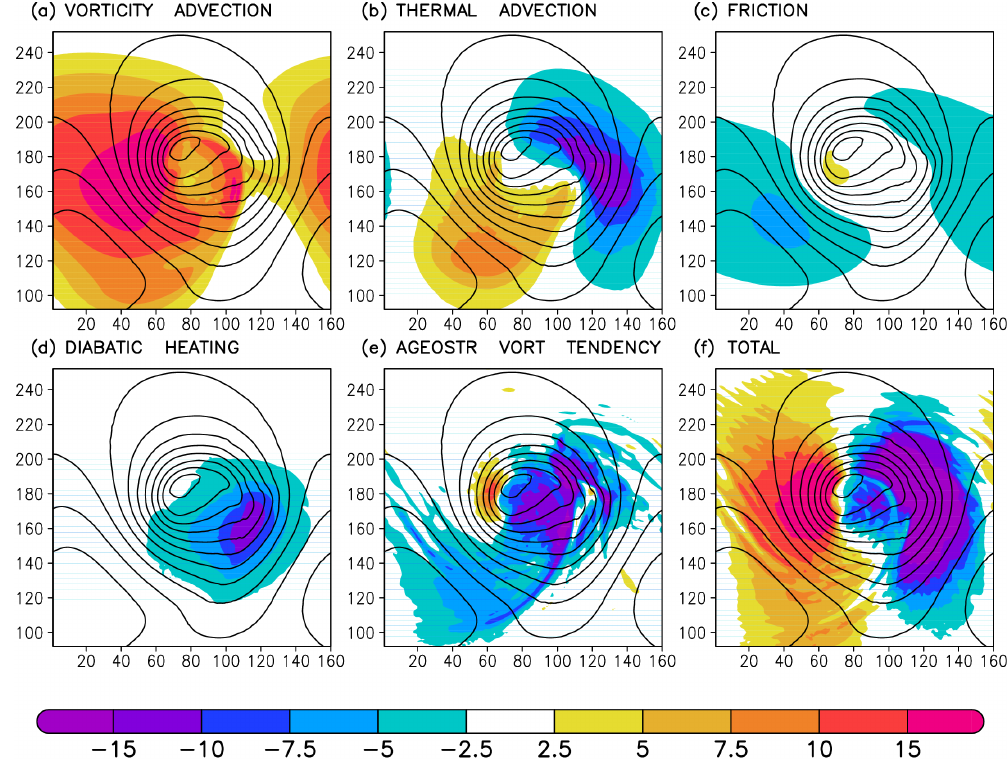
Figure 8. As Fig. 5, but for height tendency components at 900hPa level. Unit is mh − 1 . Note that the colour scale of (f) differs from Fig. 6a.